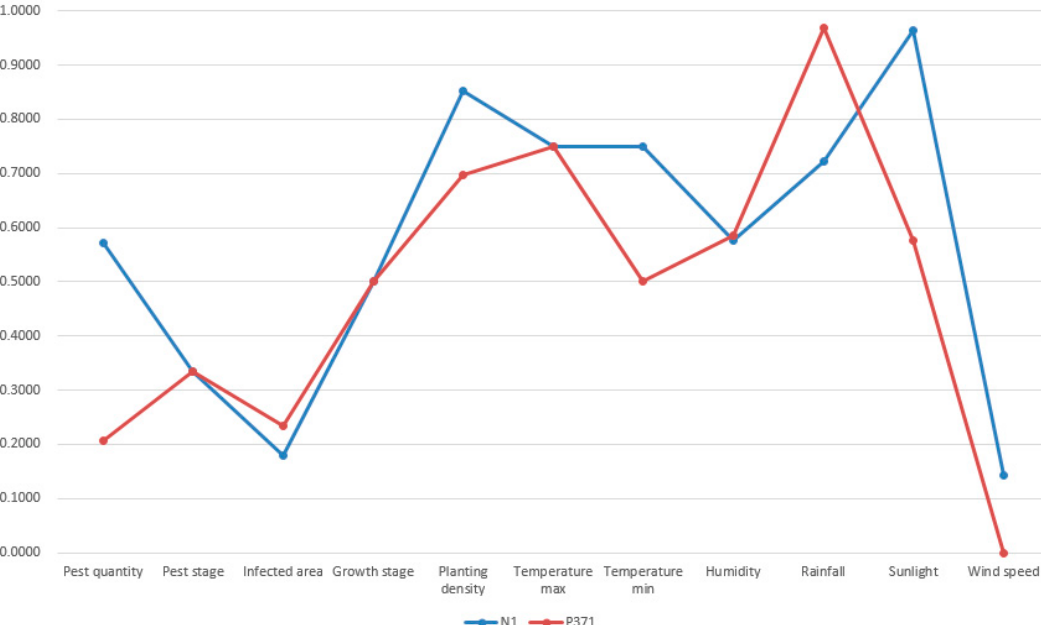
Figure 15. Visualization of the new case and past case 371.